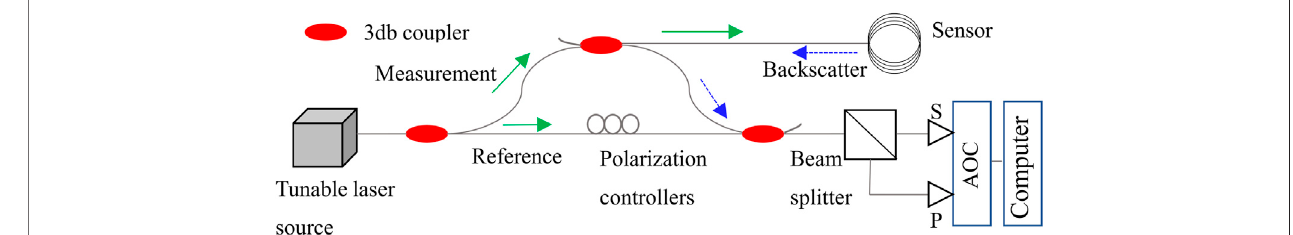
FIGURE 1 | Schematic of the OFDR principle.